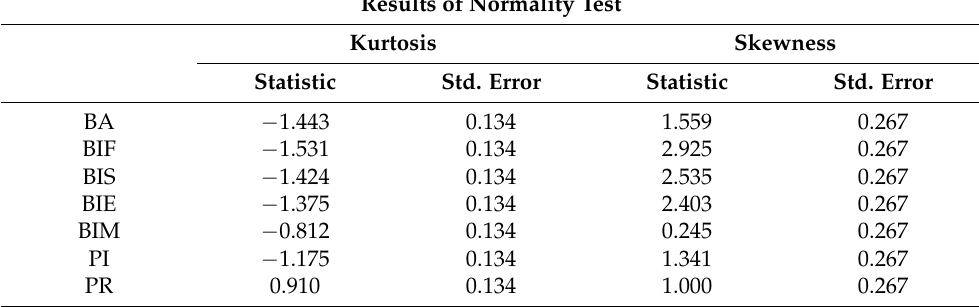
Table 4. Results of normality